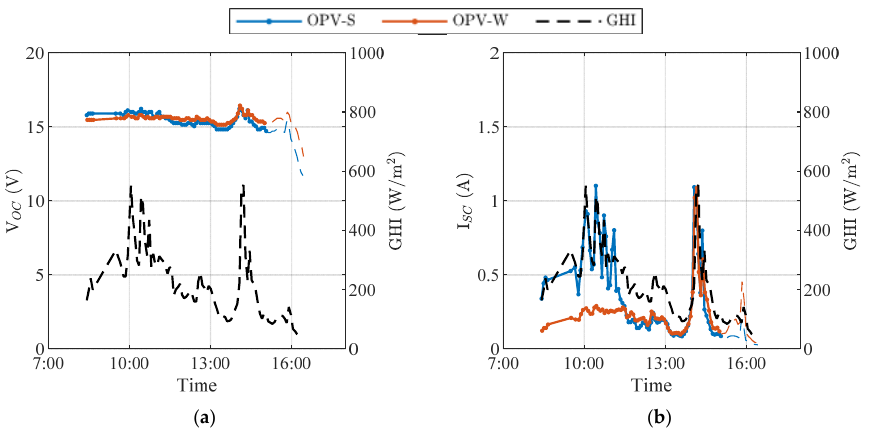
Figure 14. Example of raw data on a partially cloudy day: ( a ) open ‐ circuit voltage, V oc ; ( b ) short ‐ circuit current, I sc , recorded on 11 February 2021.